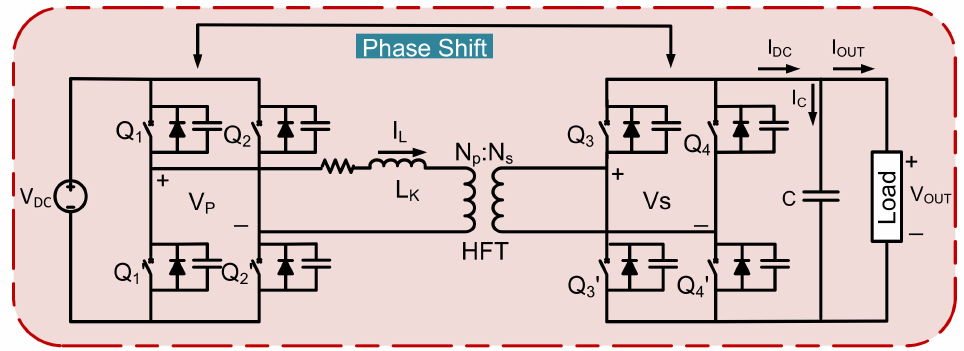
Figure 1. Schematic circuit diagram of a dual active bridge